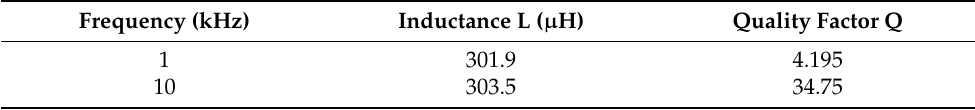
Figure 1. Diagram of designed and fabricated coil. Table 1. Electrical characteristics of the designed coil. Table 1. Electrical characteristics of the designed